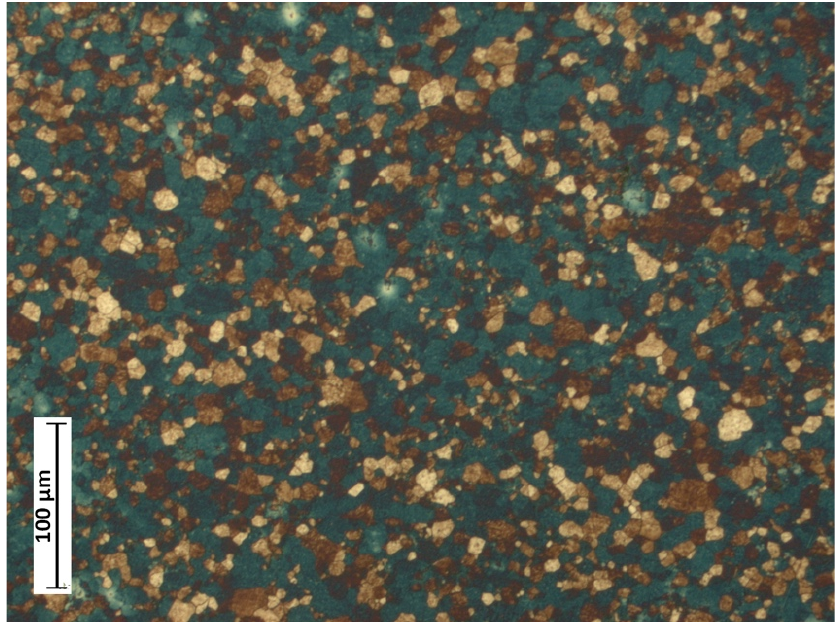
Figure 11. Microstructure after chemical etching of molybdenum sintered at 1900 °C under 70 MPa pressure, for a holding time of 30 min with a 3 mm tantalum barrier.